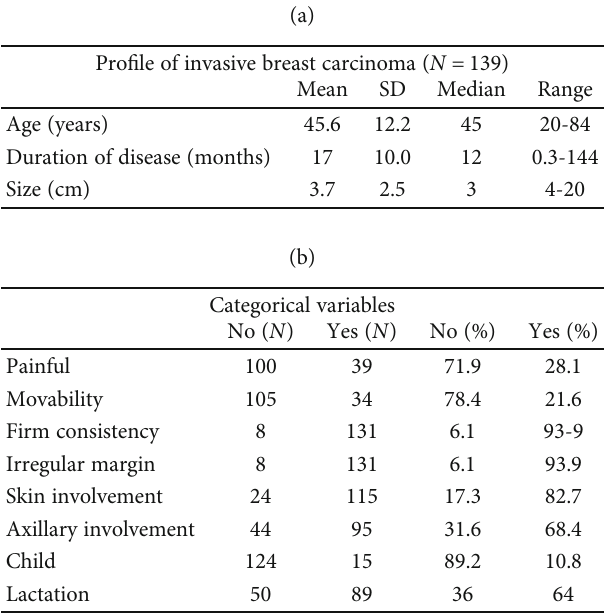
Table 6: Context variables for invasive breast